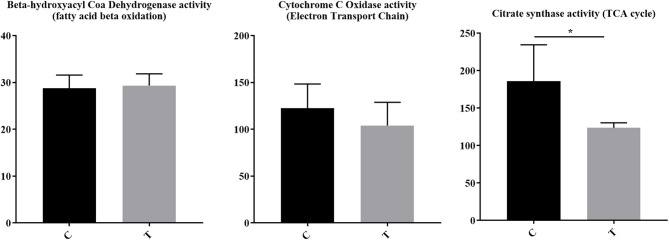
HDAC6 inhibition decreased citrate synthase activity and cytochrome c oxidase activity in NZB/W mice. Four weeks of treatment of NZB/W mice with the HDAC6 inhibitor ACY-738 lead to a significant decrease in the rate limiting enzyme of the TCA cycle (p = 0.043), and a decrease in cytochrome C oxidase activity (p = 0.053) while having no effect on beta hydroxyacyl coa dehydrogenase in splenocytes (n = 5). *P < 0.05.